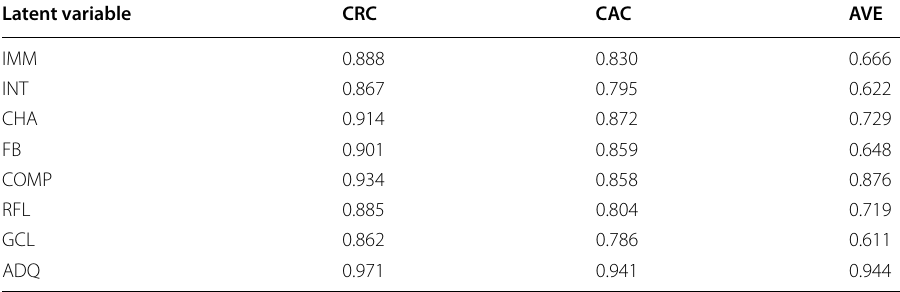
Table 3 Composite reliability, Cronbach Alpha reliability, and